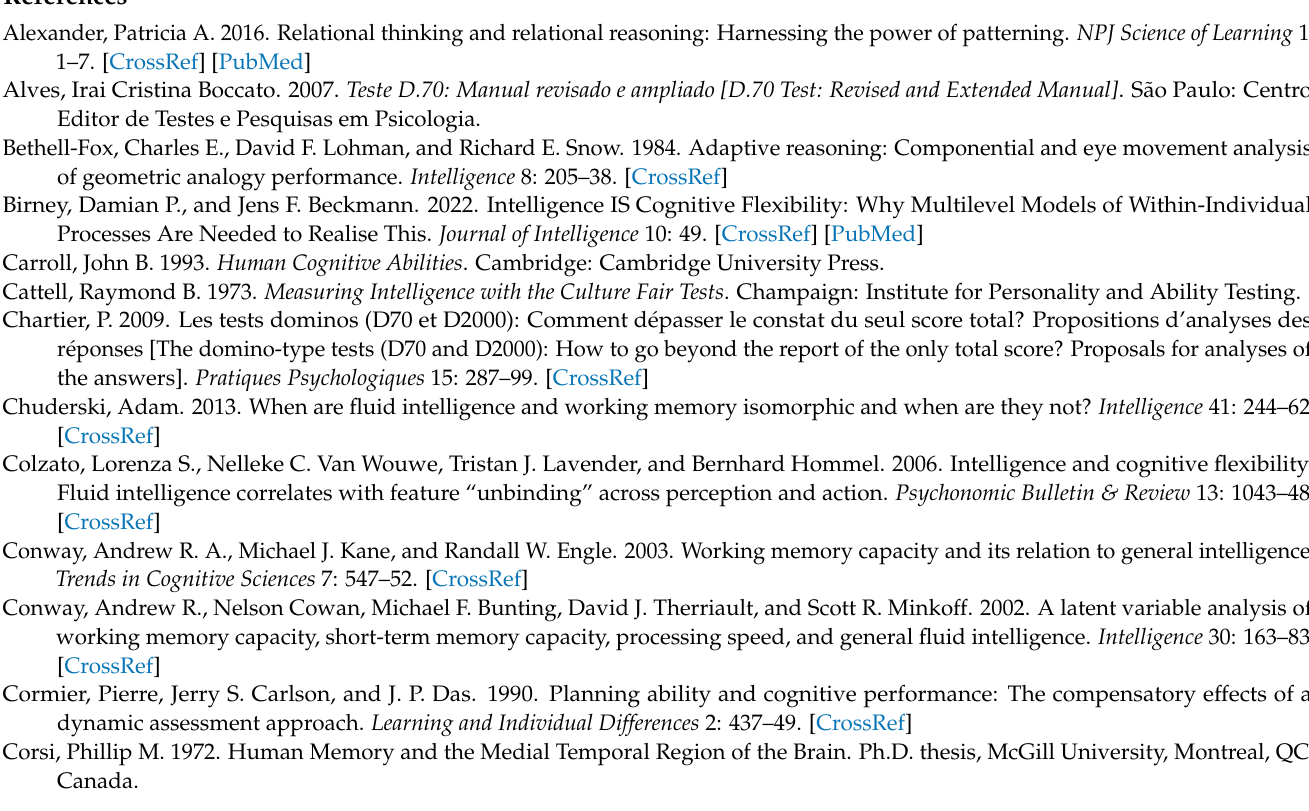
analysis; Figure S1: Scree plot of the clusterization model of Study 1; Figure S2: Average transition matrix plot of the clusters of Study 1; Figure S3: Representatives of the eye movements categorized in each cluster of Study 1; Figure S4: Raincloud plots for the eye-tracking metric variables used in the Study 1; Table S1. Descriptives of each cluster; Table S2. Correlation matrix of the cognitive measures and eyetracking metrics in Study 1; Table S3. Coefficients and measures of the LASSO regression model predicting the WMT-2; Figure S5: Scree plot of the clusterization model of Study 2; Figure S6: Average transition matrix plot of the clusters of Study 2; Figure S7: Representatives of the eye movements categorized in each cluster of Study 2; Figure S8: Raincloud plots for the eye-tracking metric variables used in the Study 2; Table S4. Descriptives of each cluster; Table S5. Coefficients and measures of the LASSO regression model predicting the